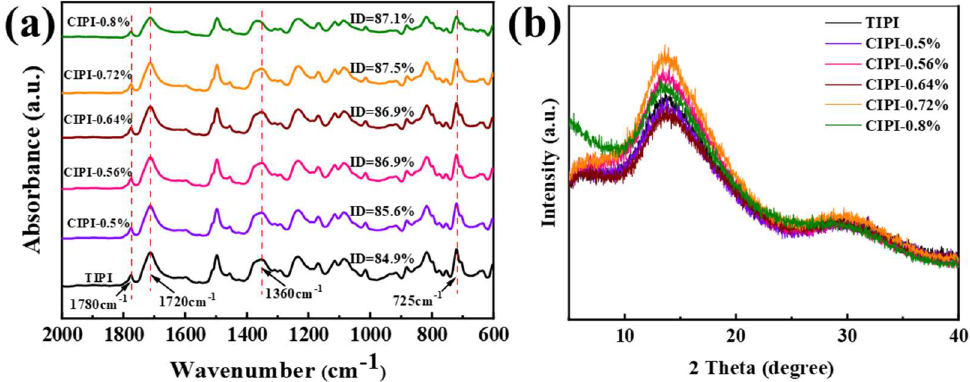
where A is the absorbance value 1360 cm − 1 peak and A 1360cm − 1 value of the C-C stretching vibration on the benzene ring.